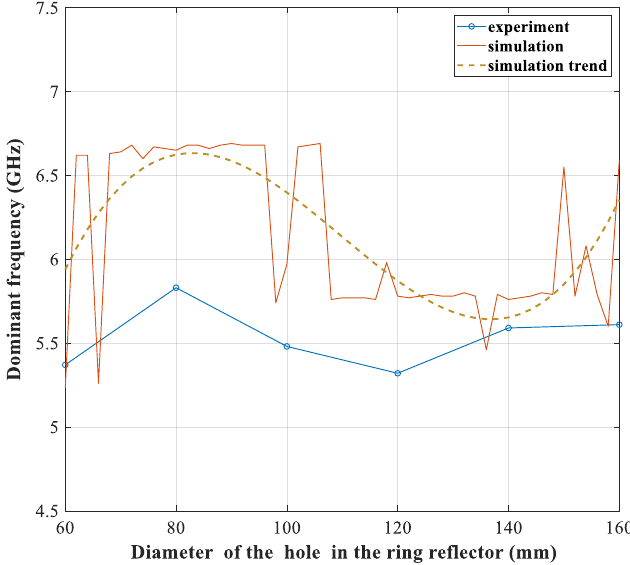
Figure 9. Dominant frequency of the simulations and experiments as a function of the anode-to-ring-reflector distance.